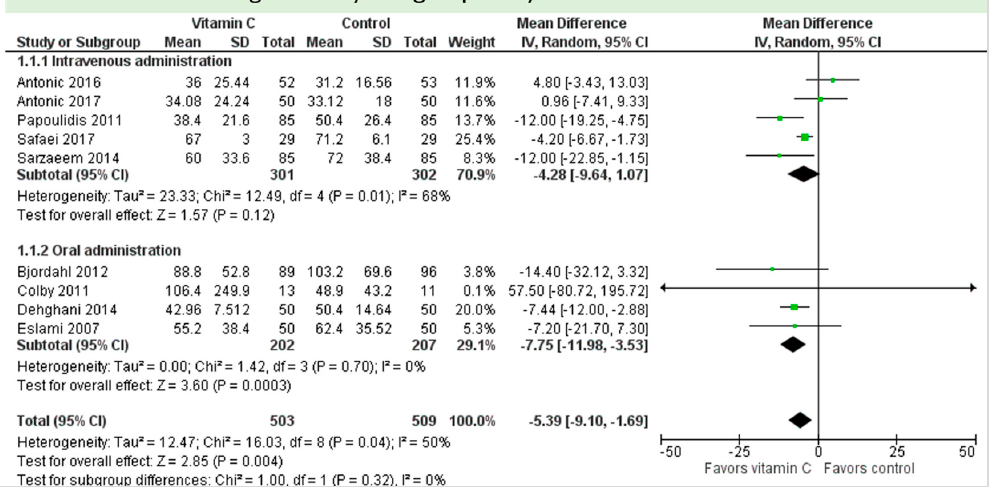
Figure 14. ICU length of stay: subgroup analysis—influence of administration route.